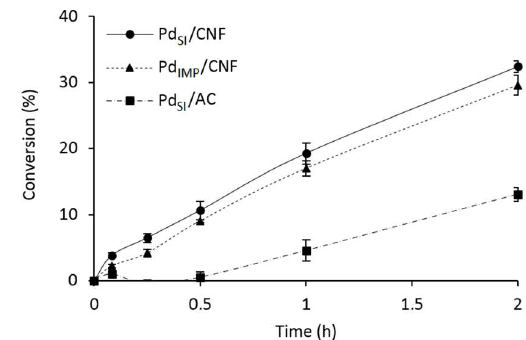
Figure 5. Formic acid dehydrogenation reaction on Pd/CNF. Comparison of preparation method. Reaction conditions: 0.5 M HCOOH 26.5 mg of catalyst (Substrate/metal molar ratio: 2000:1); 30 °C; 750 rpm; and 2 h reaction time. Table 4. Comparative catalytic activity of various Pd-based catalysts for the liquid-phase formic acid dehydrogenation at mild